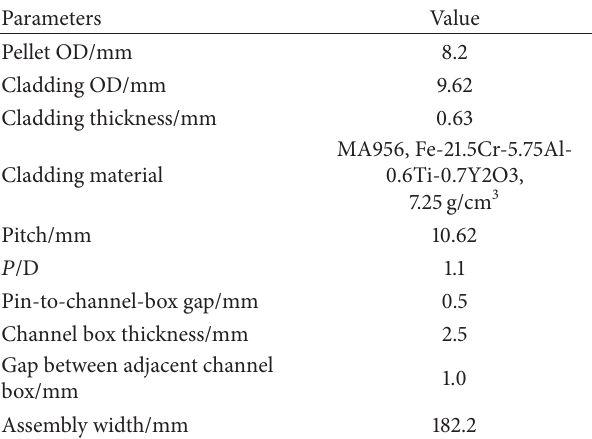
Table 2: SCFR assembly design parameters.